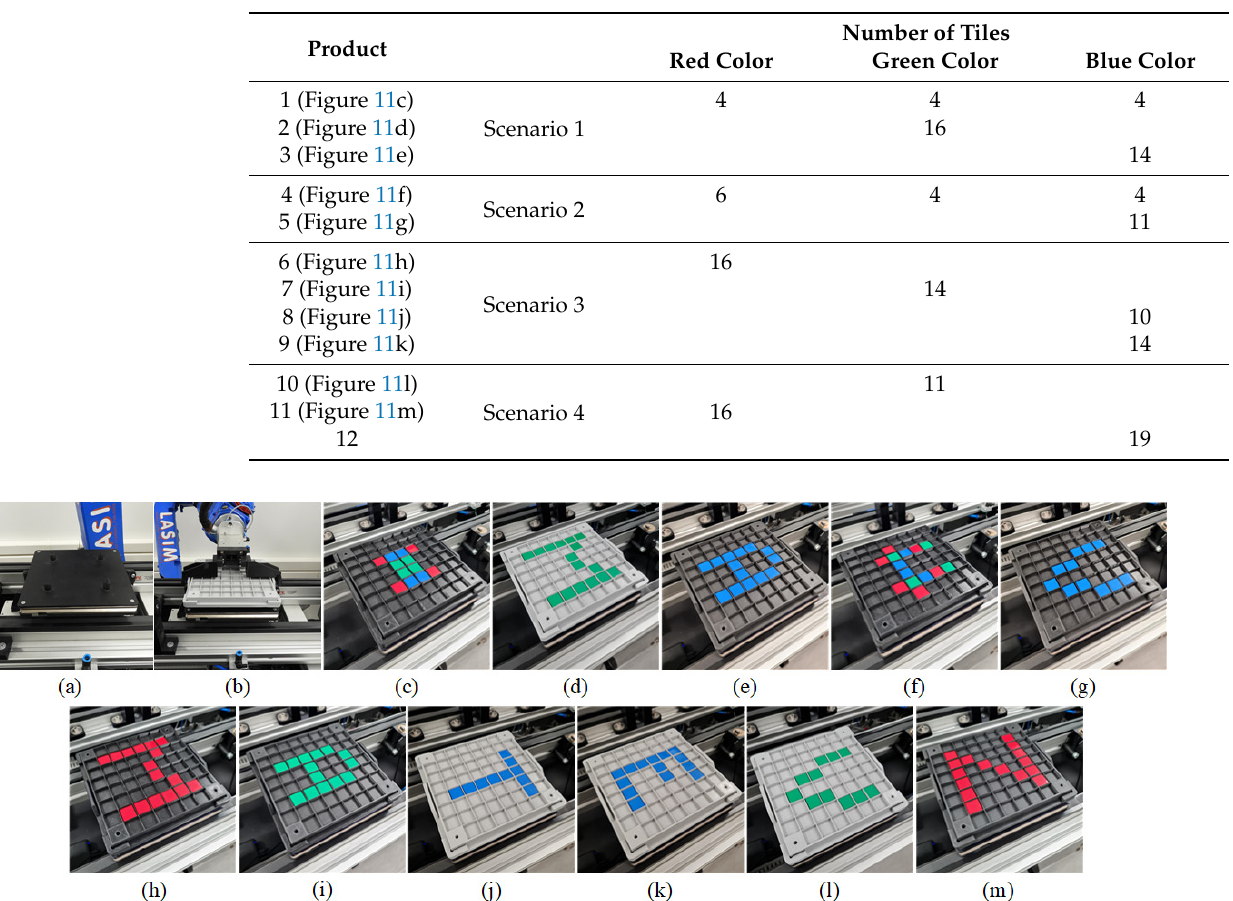
Table 1. 12 products assembled in 4 successive scenarios with different tile color and quantity.